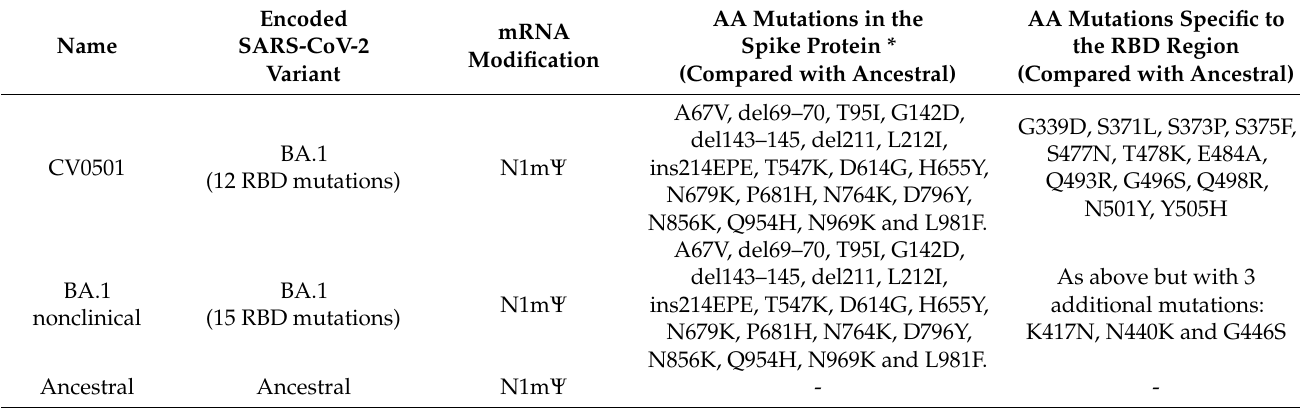
Table 1. Overview of mutations and mRNA-LNP vaccines